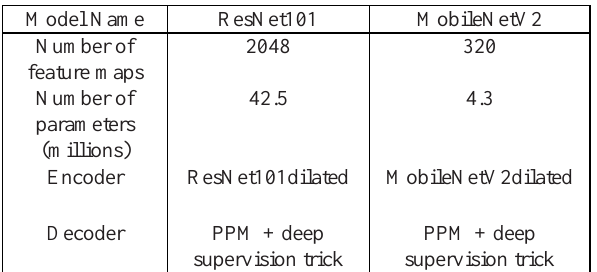
Table 1. Comparison of model architecture used in this